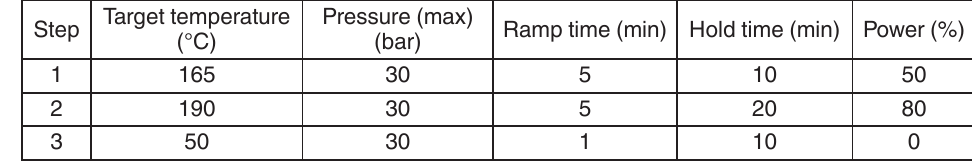
Table 1: Microwave digestion